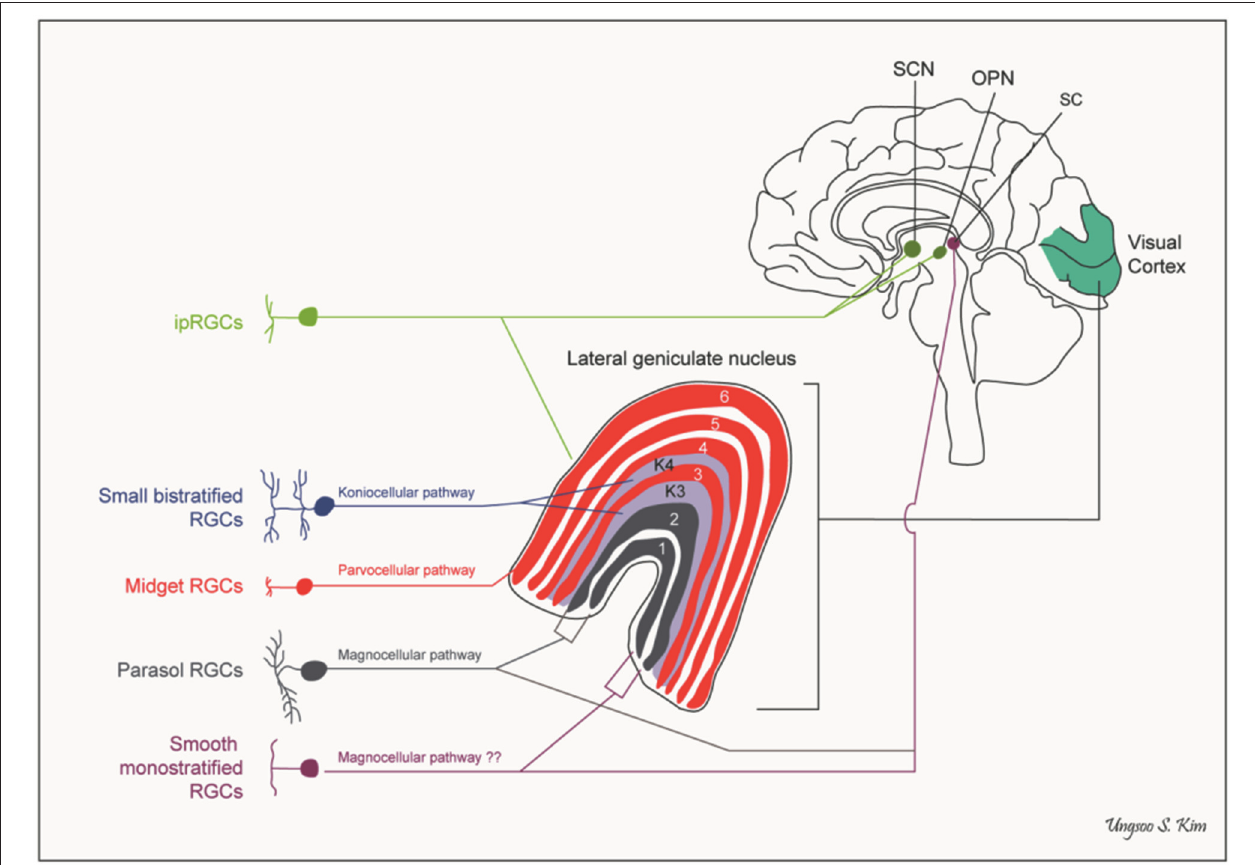
FIGURE 2 | Pathways of retinal ganglion cells. OPN, olivary pretectal nucleus; RGCs, retinal ganglion cells; SC, superior colliculus; SCN, suprachiasmatic nucleus ( by Ungsoo S. Kim ).